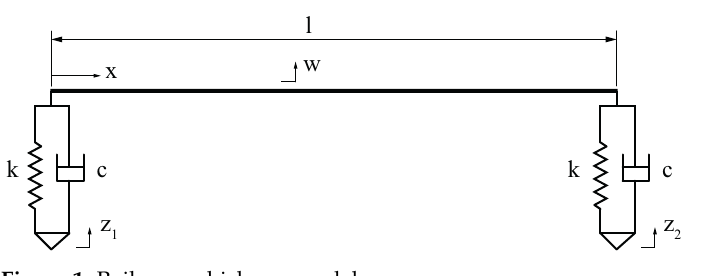
Figure 1. Railway vehicle car